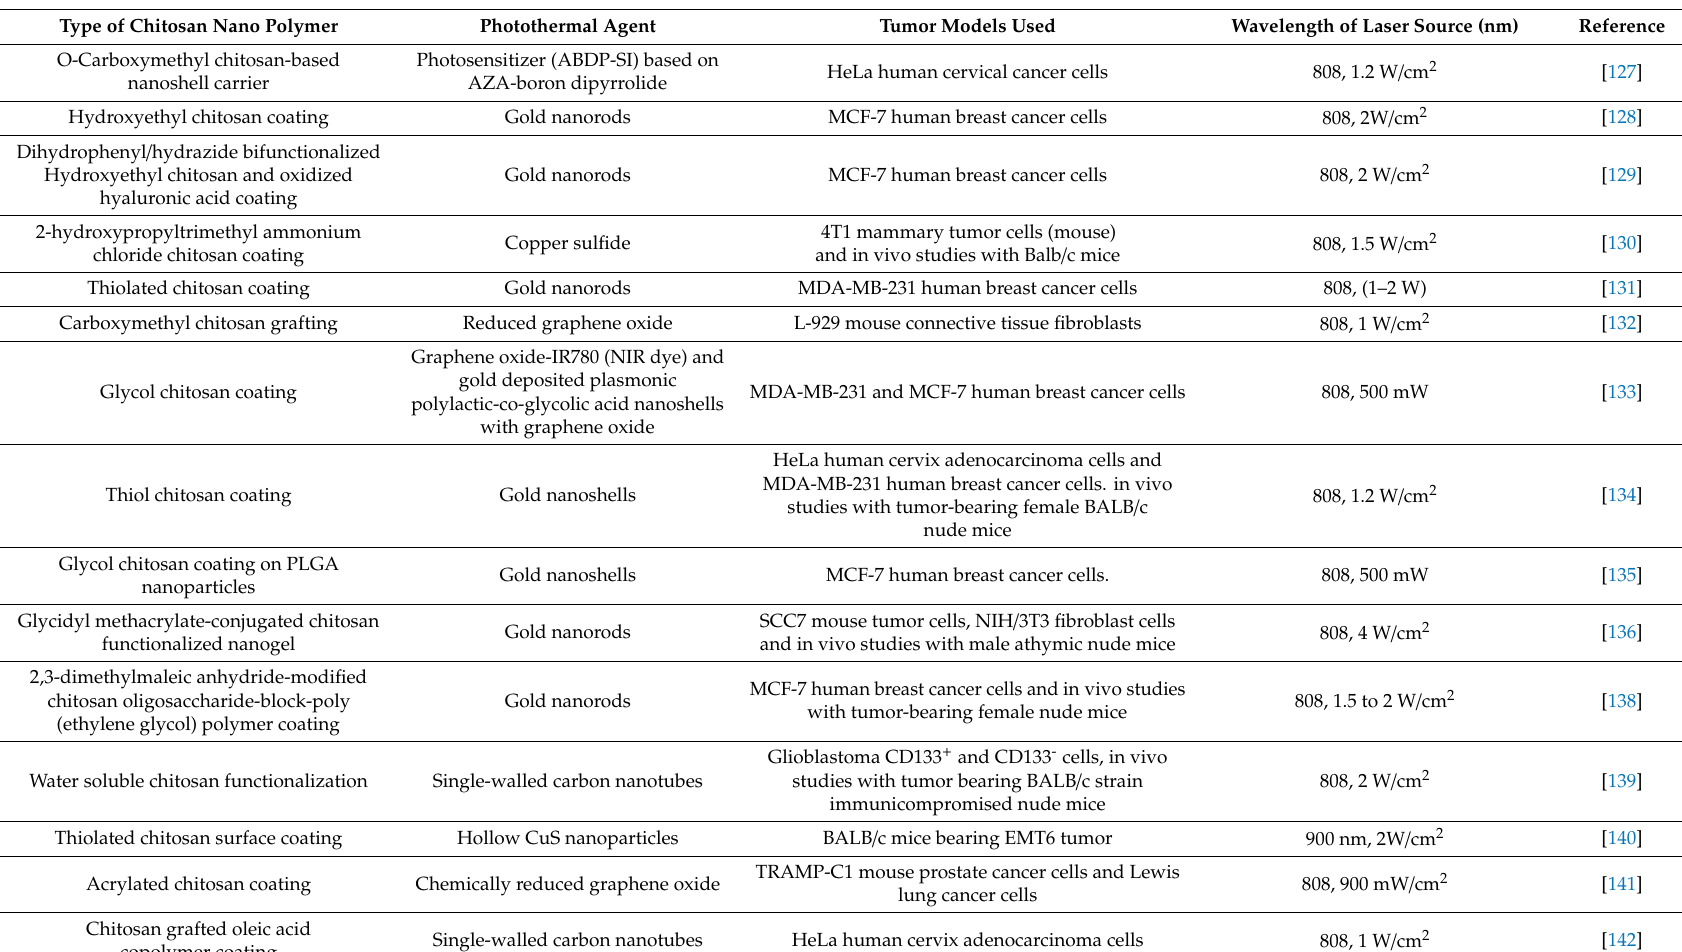
Table 6. Cancer photothermal agents synthesized with nanochitosan